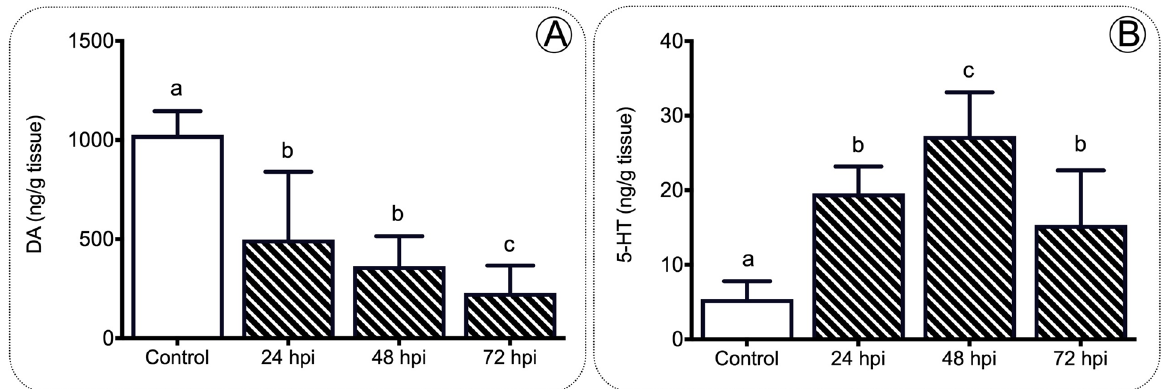
Figure 7. Monoamine content analysis in the brain of salmon. DA ( A ) and 5-HT ( B ) concentration detected in the brain of salmon after IPNv infection. Control sample corresponds to unchallenged fish. Data represent the mean ± SEM. One-way ANOVA; p < 0.05 was considered statistically significant. Different letters denote significant differences.